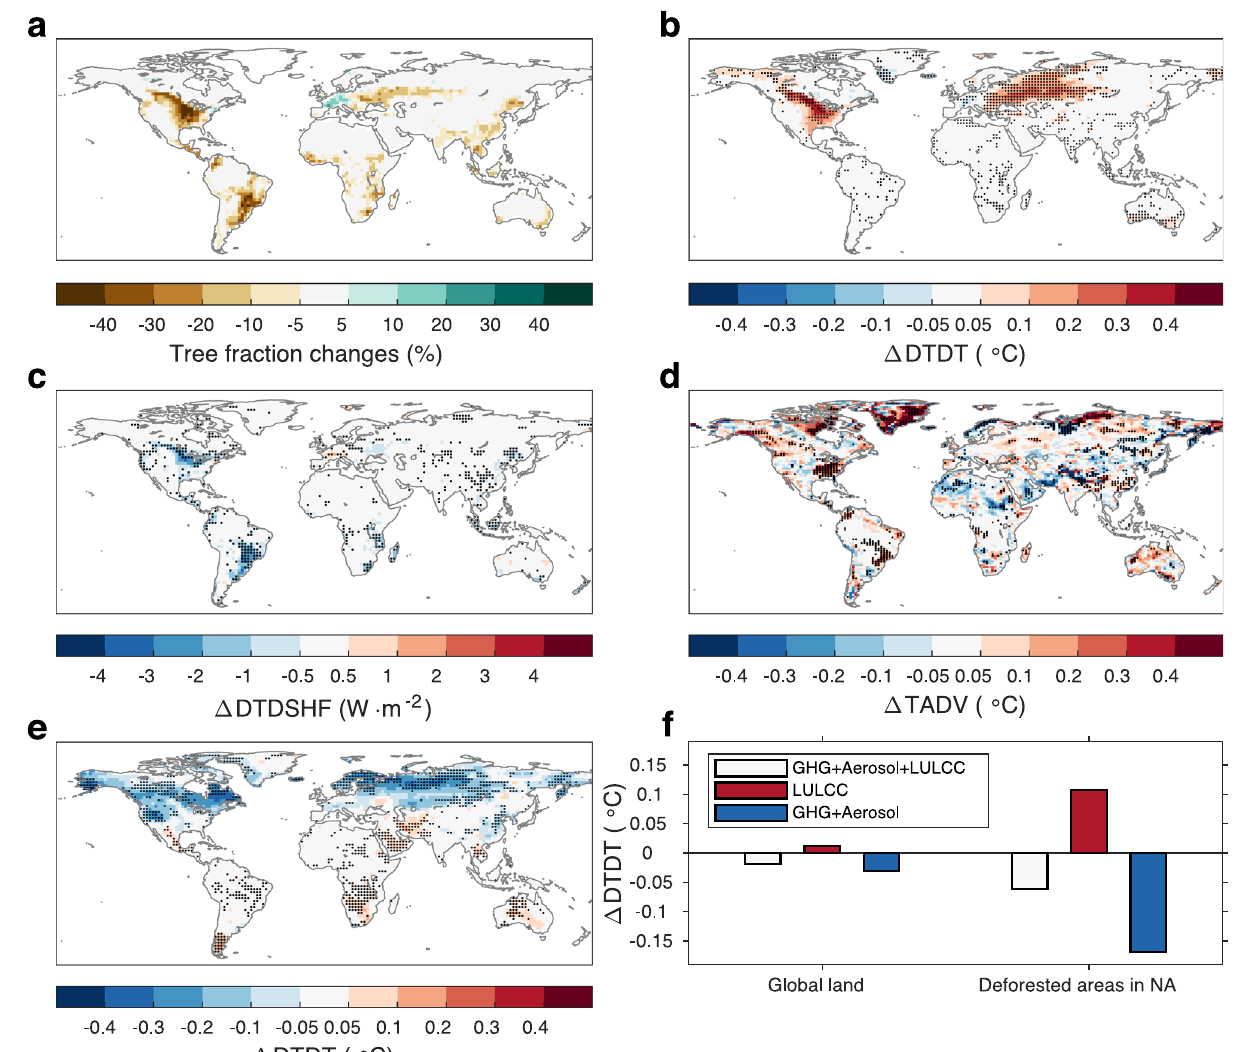
Fig. 5 | Historical tree cover changes and their effects on wintertime daily temperature variability. a Multimodel mean total tree fraction differences between the historical and hist-noLu simulations (historical minus hist-noLu) dur- ing the historical period (1850 – 2014). The biogeophysical effect of historical tree cover changes on b day-to-day temperature variability (DTDT), c day-to-day variability in sensible heat fl ux (DTDSHF), and d the near-surface horizontal tem- perature advection (TADV) in DJF (December, January and February). The DTDT andDTDTSHFchangesarefromthemeanvalueofeightmodels,andtheblackdots in b and c indicate that at least seven out of the eight models agree on the sign of